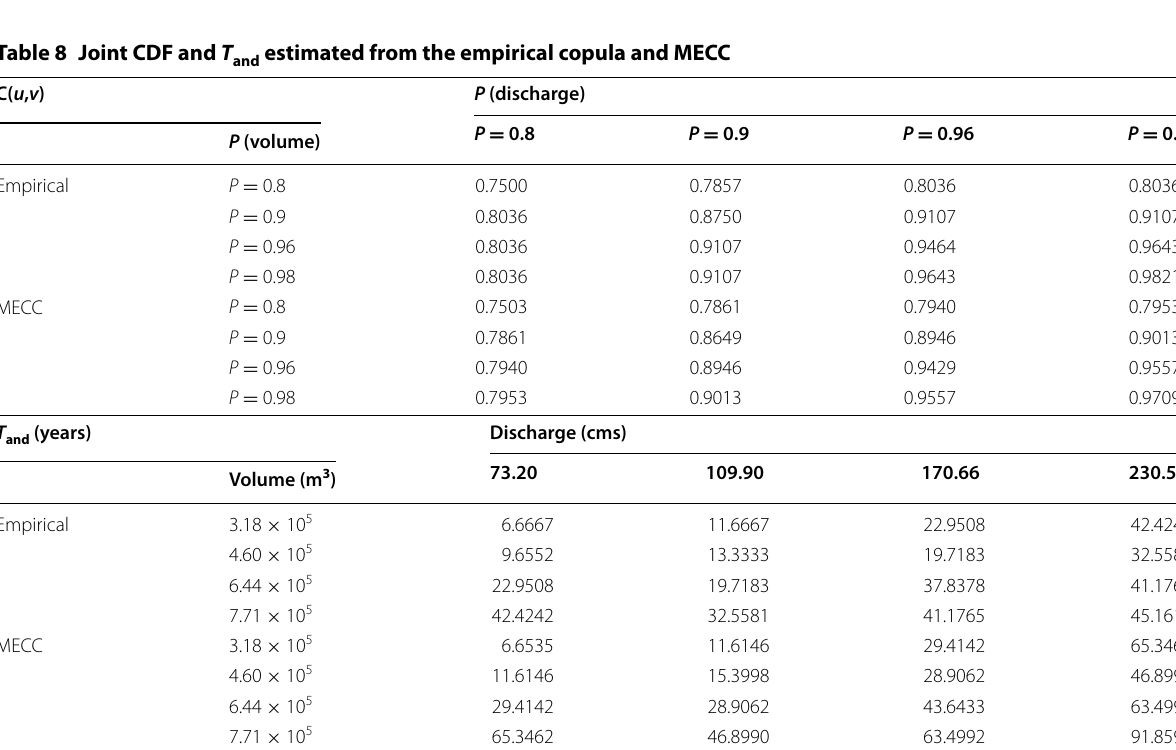
P 0.8) was less than that computed with larger = peak discharge (e.g., Q 109.9 cms). This was true = in reality, since it was more likely for ( Q 109.9 ≥